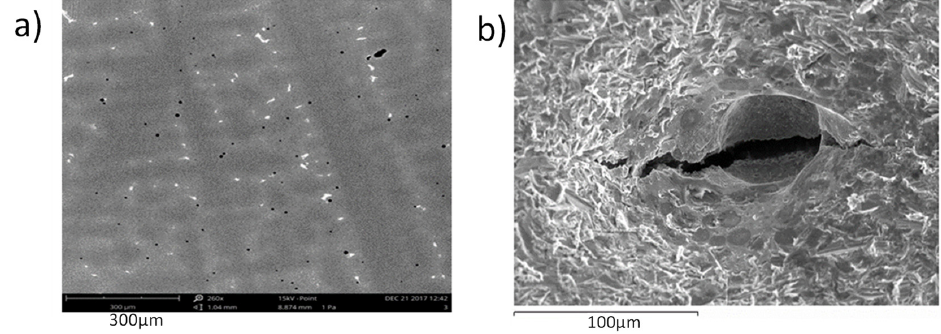
Figure 12. Microstructure and defects of Casted samples. ( a ) Porous and precipitates. ( b ) Porous with crack due to the volume contraction.